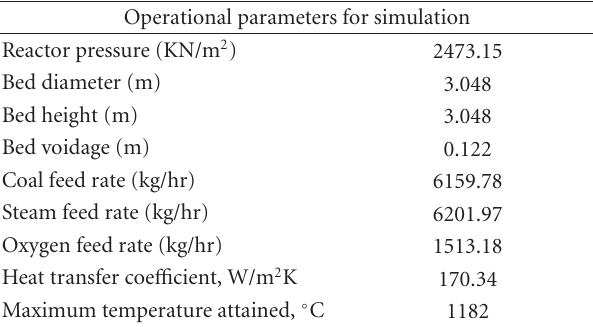
Table 4: Simulation model operational parameters.